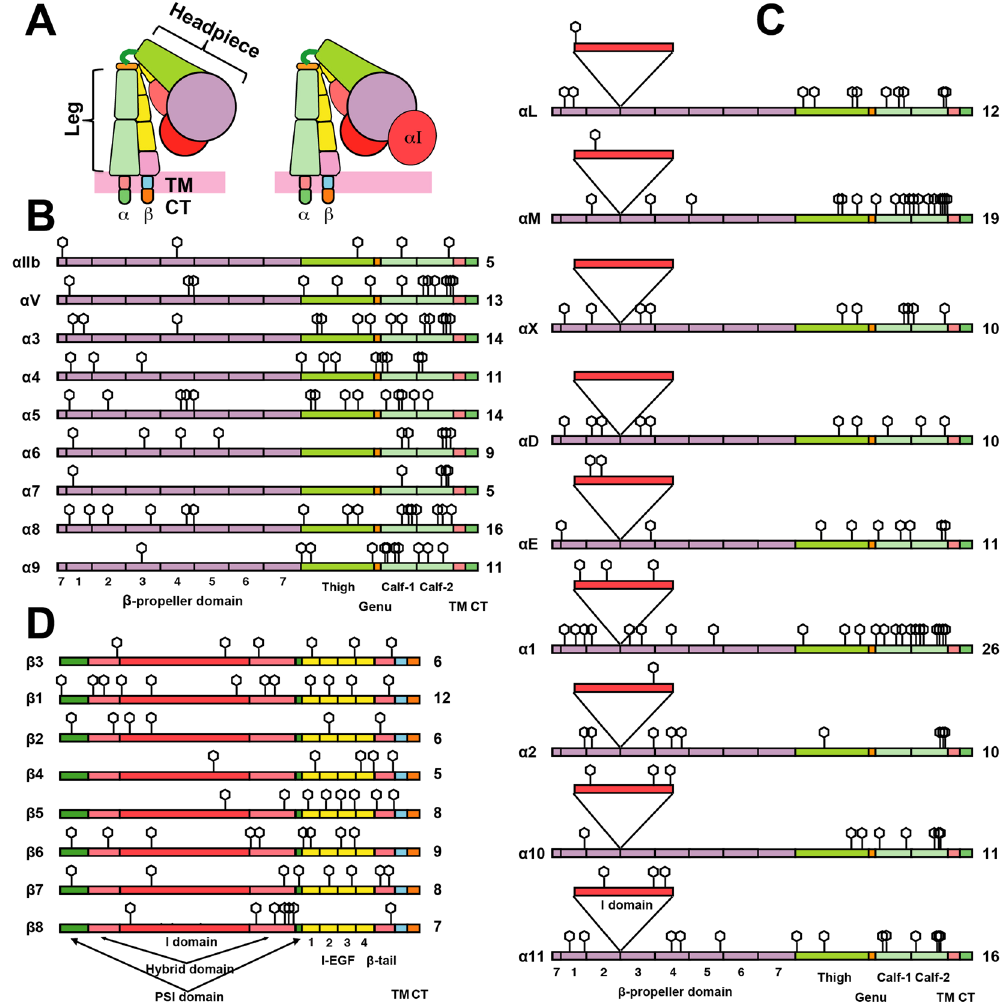
Figure 1. Integrin structure and N-linked glycosylation. (A) Cartoon models of integrin in the bent conformation. The domains are color-coded as same as panels B – D . (B , C) The distribution of potential N-glycan sites in the integrin α subunits without ( B ) or with ( C ) the α I-domain. The 7 blades of β -propeller domain are labeled. (D) The distribution of potential N-glycan sites in the integrin β subunits. The numbers of predicted N-linked glycosylation sites are shown on the right for each integrin